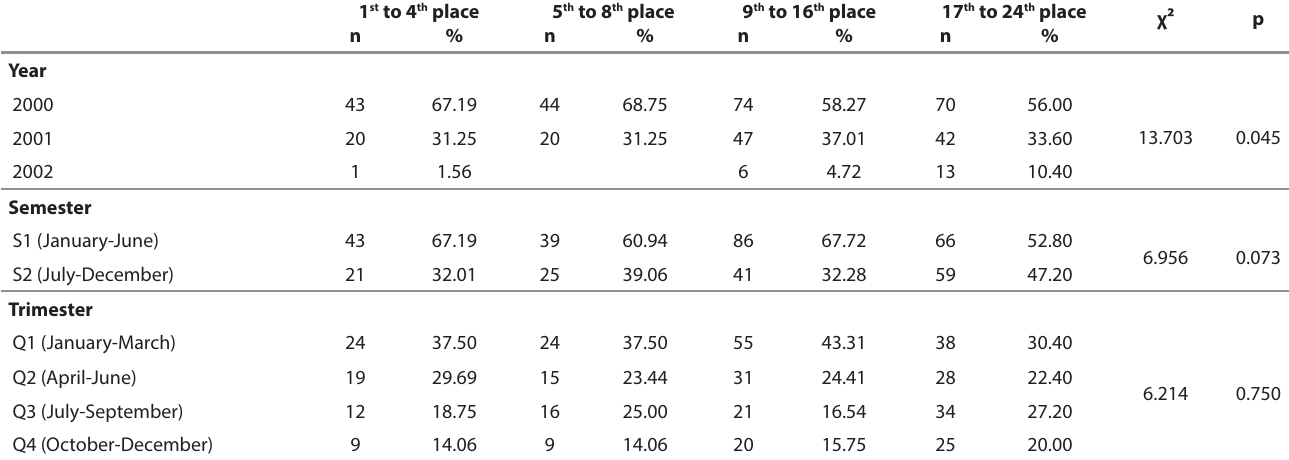
TABLE 3. Number, percentage distribution, and association (χ²) between birth year, semester, and trimester and the team’s final classification 1 st to 4 th